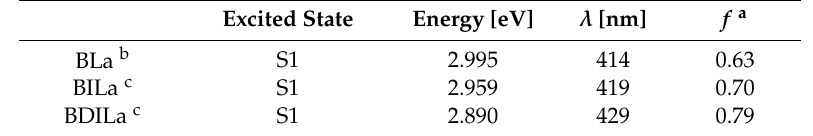
Figure 2. Highest occupied molecular orbital-lowest unoccupied molecular orbital (HOMO-LUMO) transition energies and wave function of BLa, BILa, and BDILa calculated using the density functional theory (DFT) method with the CAM-B3LYP functional and 6-31G(d,p) basis set (LanL2DZ basis for I atoms). Table 2. Selected transition energies and wave function of BIa, BILa, and BDILa in the water solution.